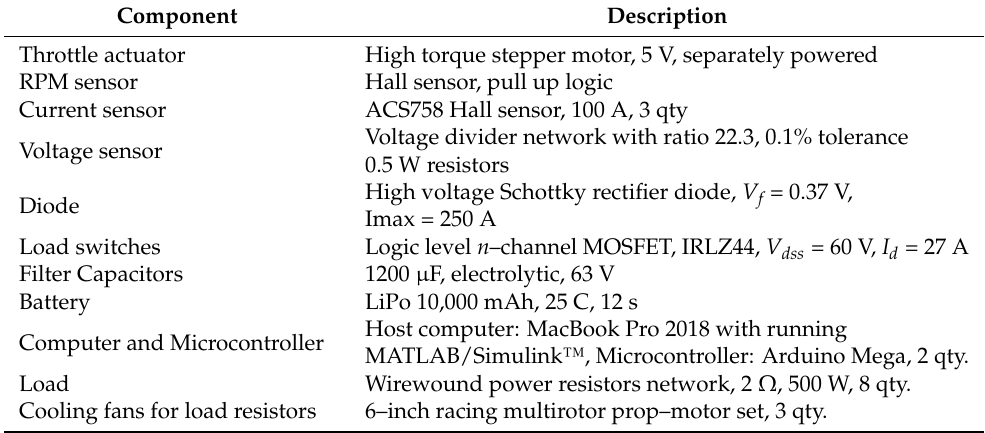
Table 3. BPMS machine technical